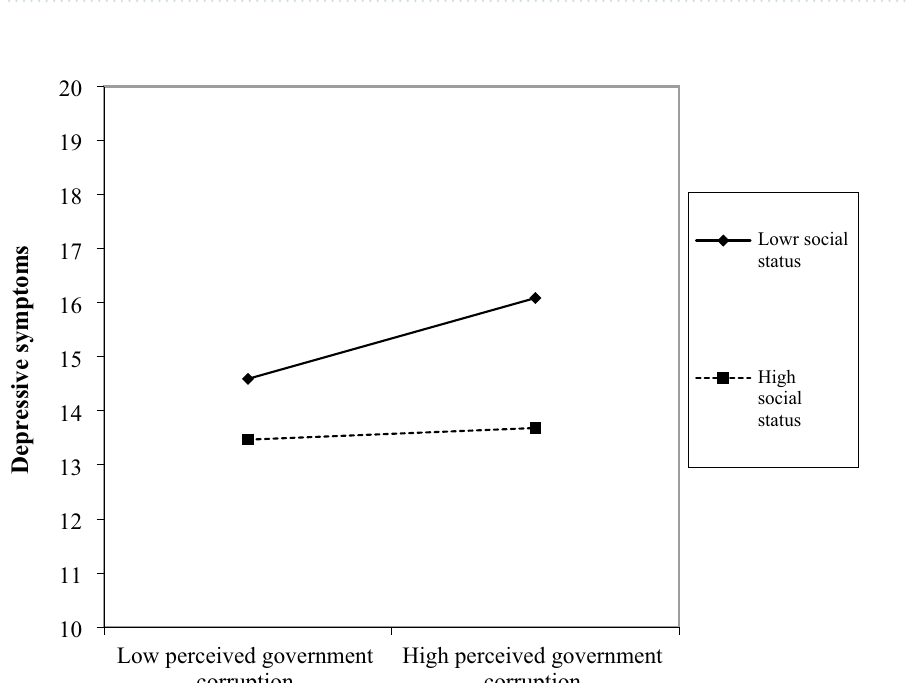
Figure 2. The moderating role of social status. High or low levels of perceived government corruption are to add or subtract one standard deviation from the average value of perceived government corruption. High or low levels of social status are to add or subtract one standard deviation from the average value of social